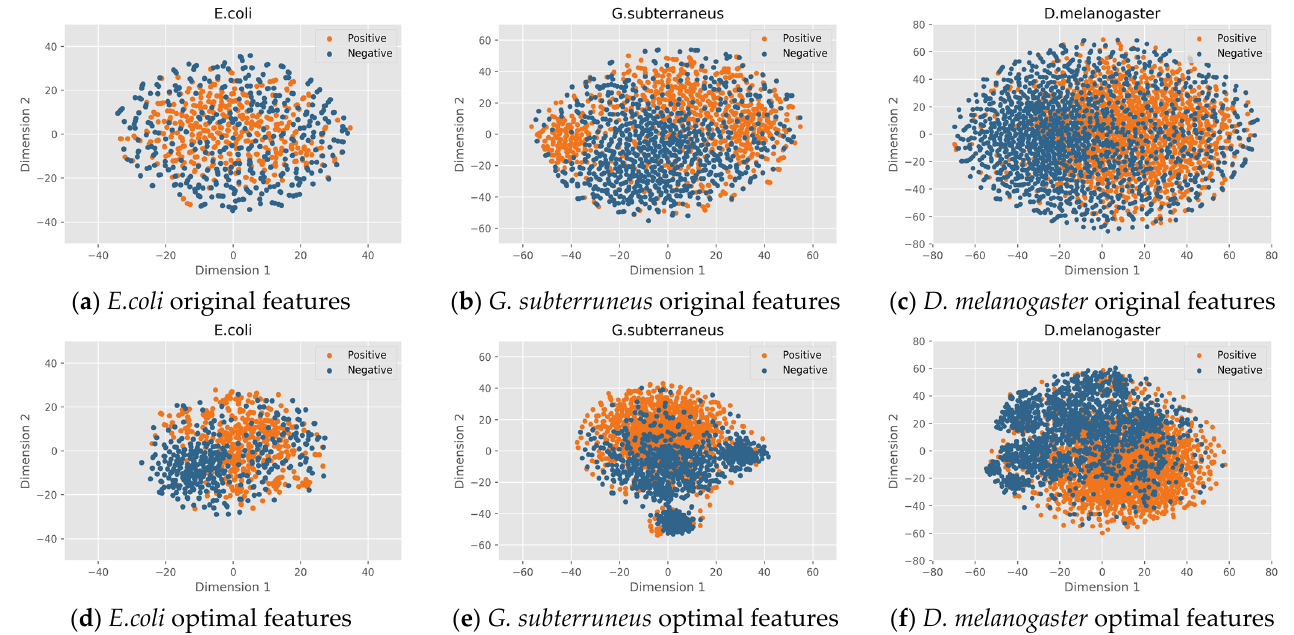
Figure 5. t ‐ SNE visualization of the E.coli , G. subterruneus, and D. melanogaster datasets in a two ‐ dimensional feature space. Figure 5. t-SNE visualization of the E.coli , G. subterruneus , and D. melanogaster datasets in a two-dimensional feature